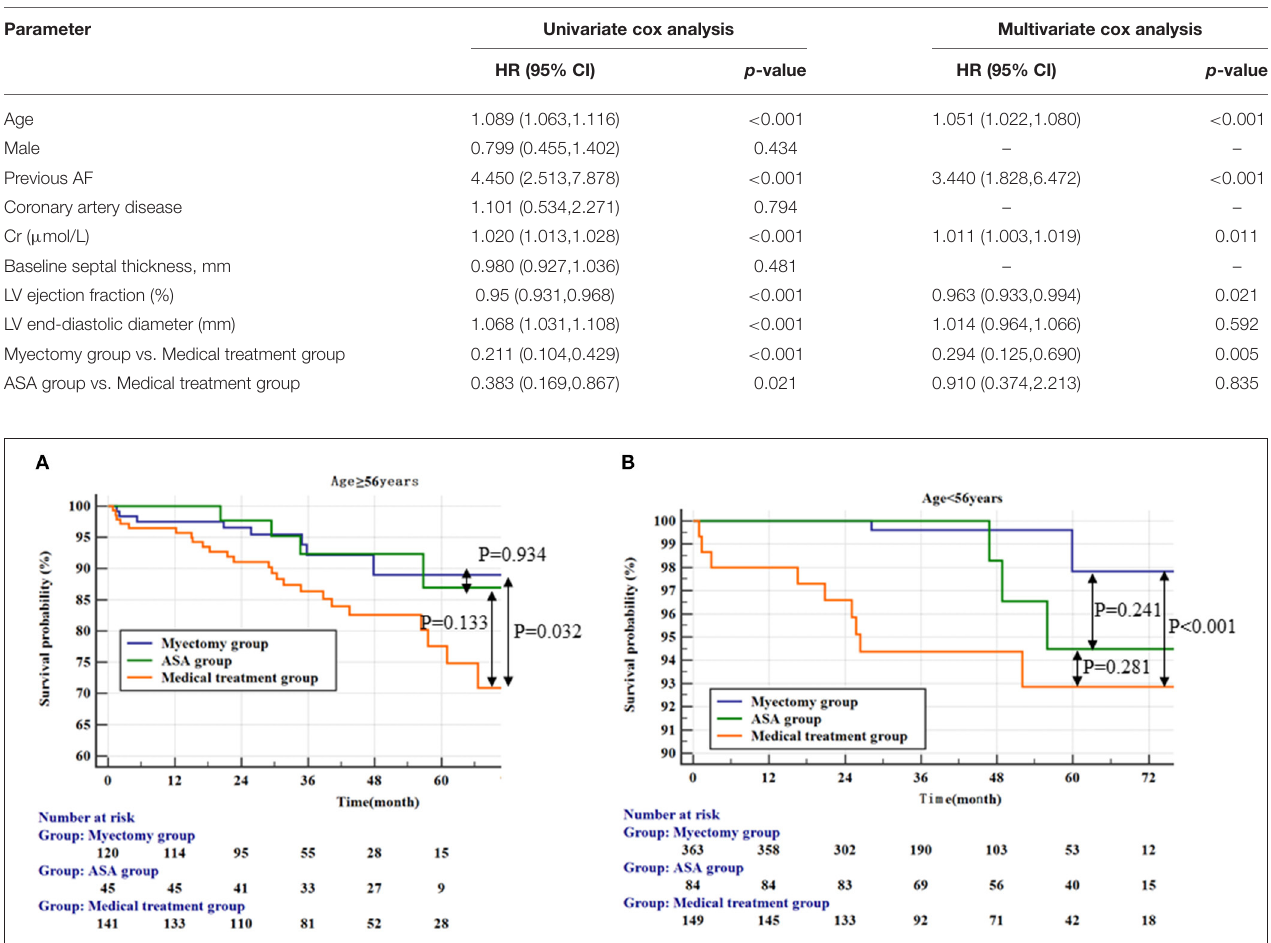
FIGURE 2 | Kaplan–Meier curves comparing the probability of outcomes stratified by treatment strategies. (A) Represents the population ≥ 56 years; (B) Represents the population < 56 years.